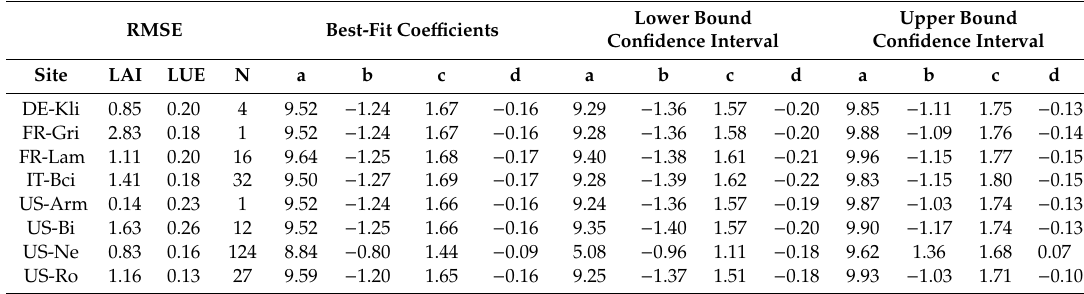
Table 4. Leave-one-site-out FLUX LANDSAT regression retrieval performance using Equations (4) and (5). a, b, c, and d are the leave-one-site-out regression coe ffi cients defined in Equations (4) and (5). Lower Bound RMSE Best-Fit Coe ffi cients Confidence